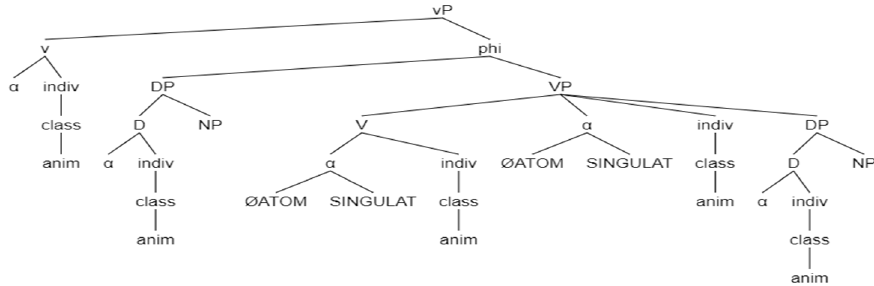
Figure 24. After insertion of v*, inheritance, Agree, and labeling.